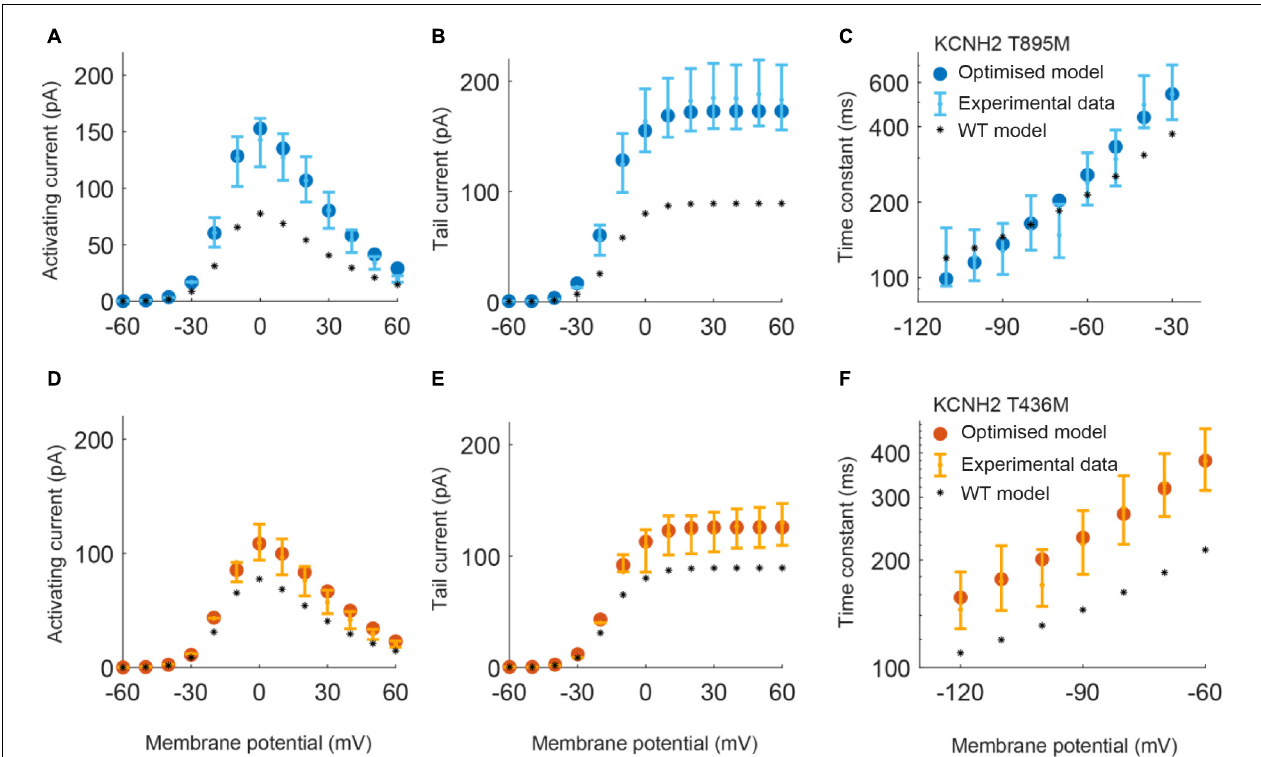
FIGURE 2 | Resulting I Kr currents and time constants obtained by using the parameters estimated with the optimization procedure of the KCNH2 T895M (blue) and KCNH2 T436M (orange) models. Error bars indicate experimental data (target) and closed circles correspond to simulation results; wild-type (WT) model results are represented by black stars. (A,D) Activating current. (B,E) Tail current. (C,F) Deactivation time